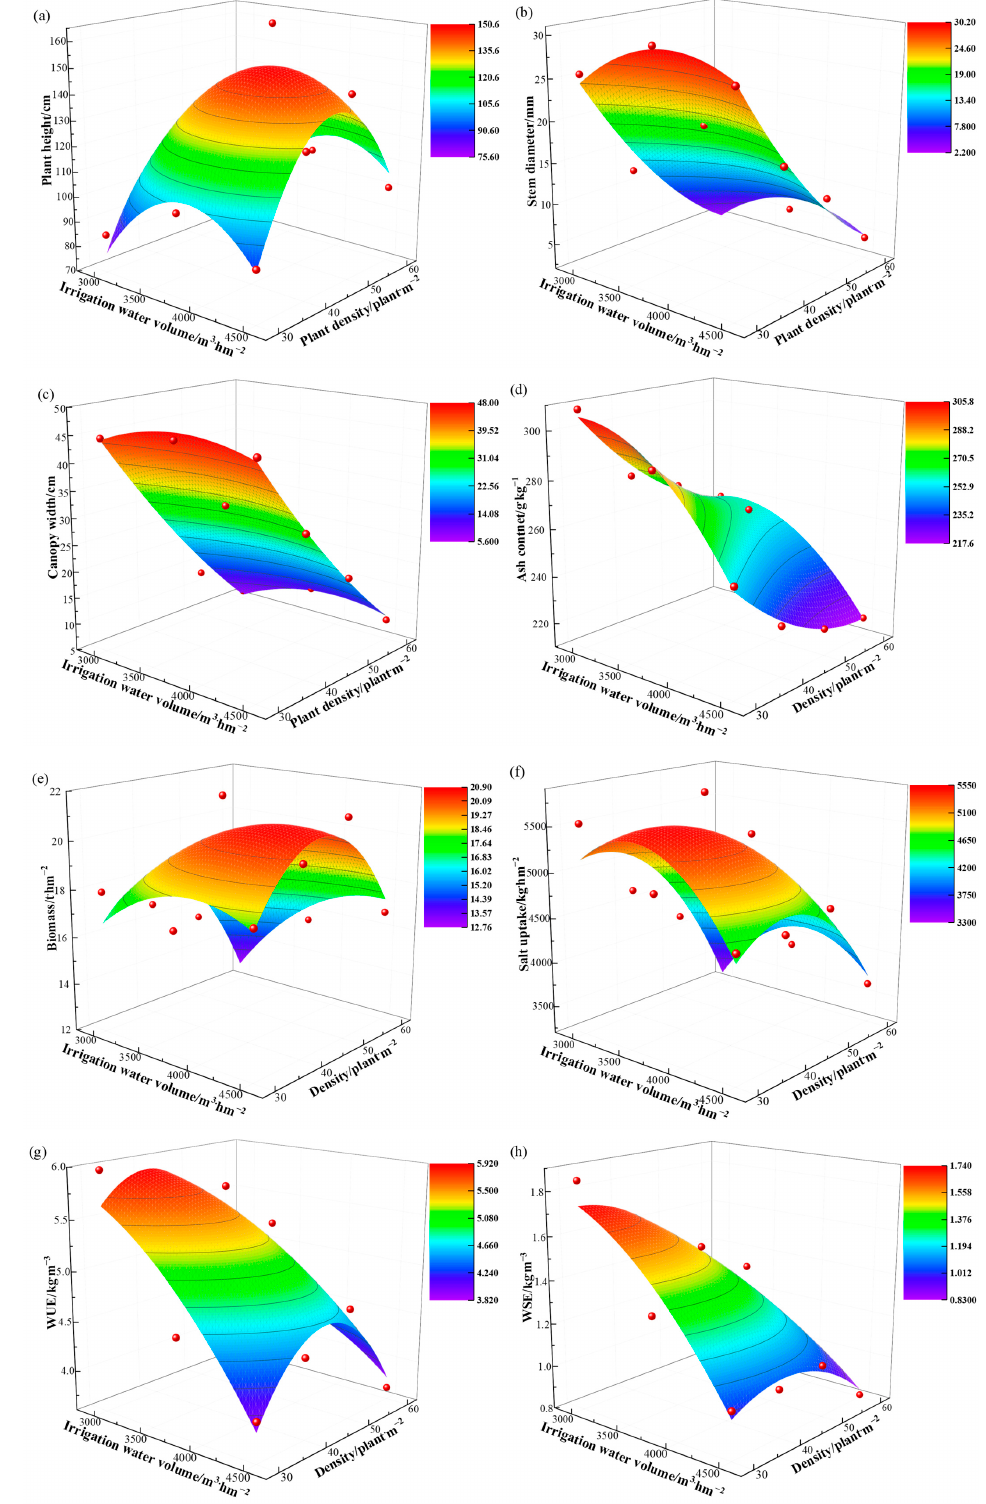
Figure 1. Three-dimensional surface map of the irrigation water and density input for each evaluation indicator. In the figure ( a – h ) represent plant height, stem diameter, canopy width, ash content, biomass, salt uptake, WUE and WSE, respectively. The red dots in the figure represent the field observation values of the evaluation indicators.